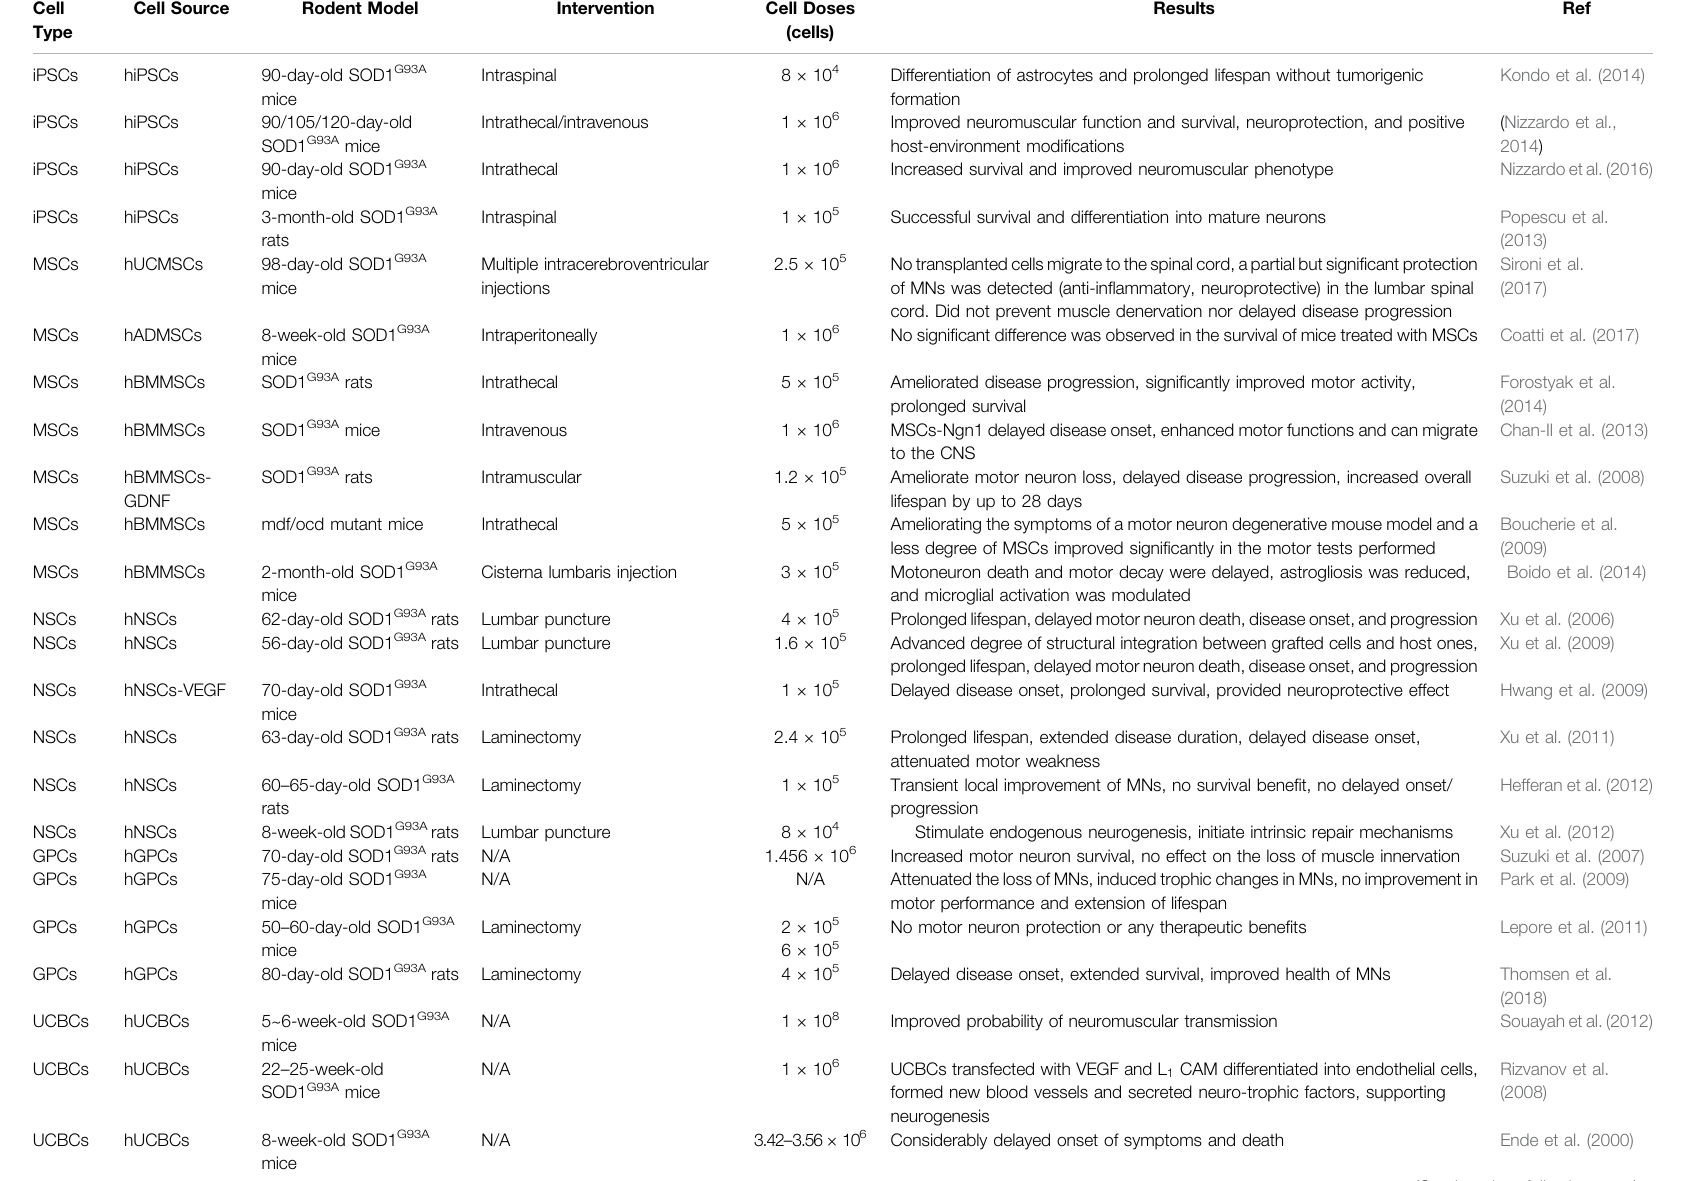
TABLE 2 | Preclinical studies of human cells in rodent